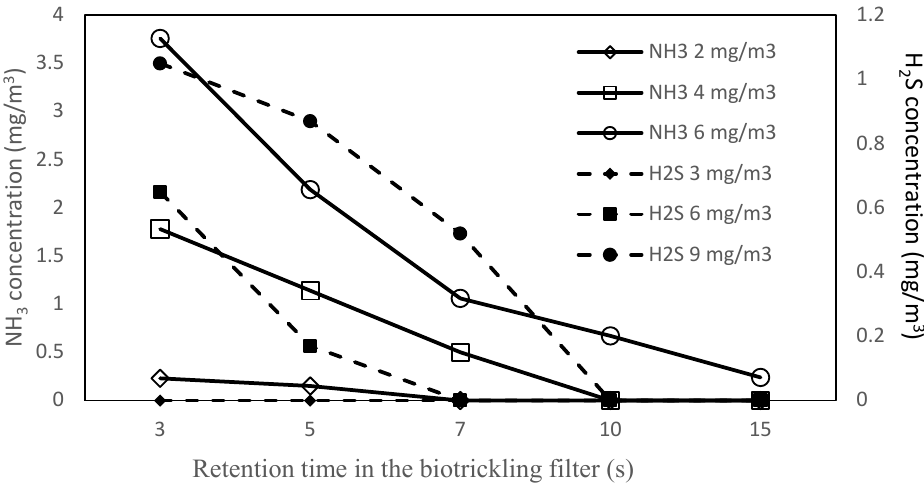
Figure 4. The ammonia and hydrogen sulfide removal by combined process.